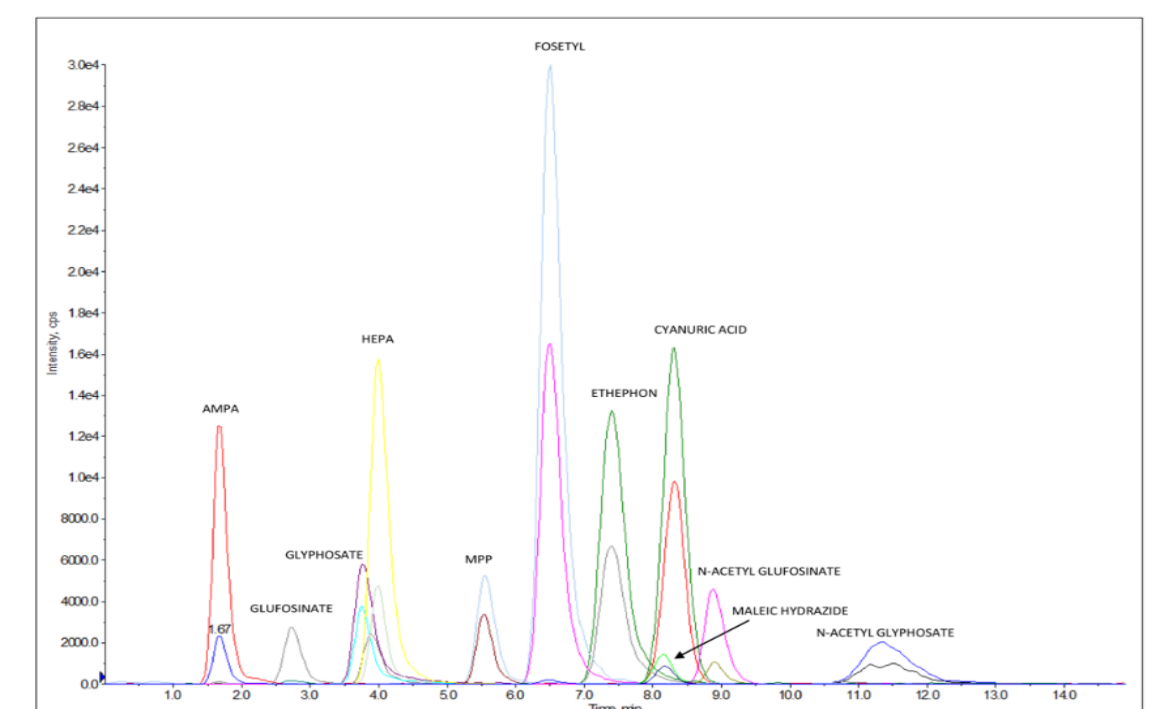
Figure 2. Chromatogram of bovine fat extract spiked at 0.040 mg/kg for AMPA, cyanuric acid, ethephon, fosetyl Al, glyphosate, HEPA, maleic hydrazide, and N-Acetyl-glyphosate, and at 0.008 mg/kg for glufosinate ammonium, MPP, and NAG. Concentration levels for ILIS were 0.006 mg/kg for AMPA- 13 C, 15 N, cyanuric acid 3 C 3 , ethephon D 4 , fosetyl Al D 15 , glyphosate 2- 13 C, 15 N, HEPA D 4 , and N-Acetyl-glyphosate 13 C 2 , 15 N, and the levels were 0.0012 mg/kg for glufosinate ammonium D 3 , MPP D 3 , and NAG D 3 . For each native pesticide and relative ILIS, one ion is reported.